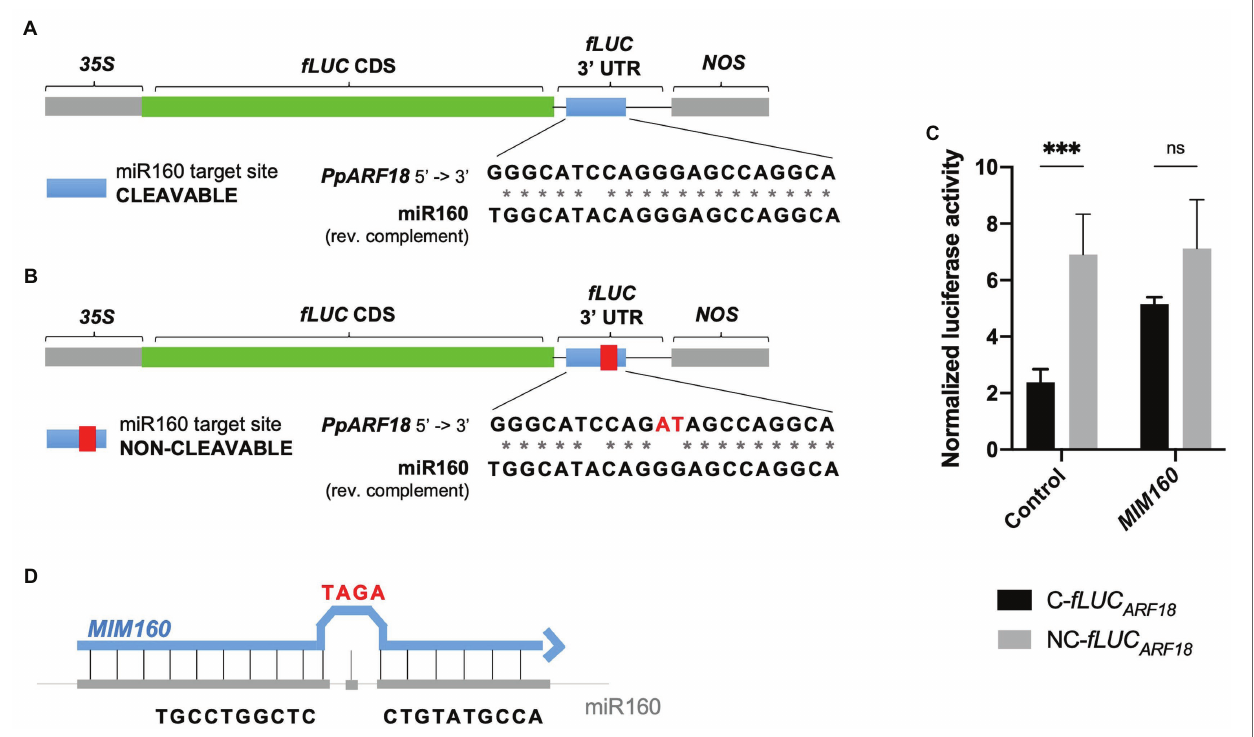
FIGURE 2 | Firefly Luciferase ( fLUC ) microRNA (miRNA) reporters used to monitor miR160 activity in Arabidopsis protoplasts. (A) The P. pinaster miR160 (ppi- miR160) AUXIN RESPONSE FACTOR 18 in Pinus pinaster (Pp ARF18 ) target site was introduced in the 3 ′ UTR region of fLUC , generating the cleavable reporter. (B) The non-cleavable reporter was produced harboring mutations in positions corresponding to the 10th and 11th nucleotides of the mature miR160 sequence (showed in red). (C) Normalized luciferase activity of cleavable (C -fLUC ) and noncleavable (NC -fLUC ) reporters as a measure of miR160a activity. Asterisks (*) represent significant differences ( p < 0.001) obtained by two-way ANOVA and Sidak’s multiple comparison test. (D) Target mimic with a modification of the central sequence by addition of three extra nucleotides (C to TAGA), resulting in a bulge